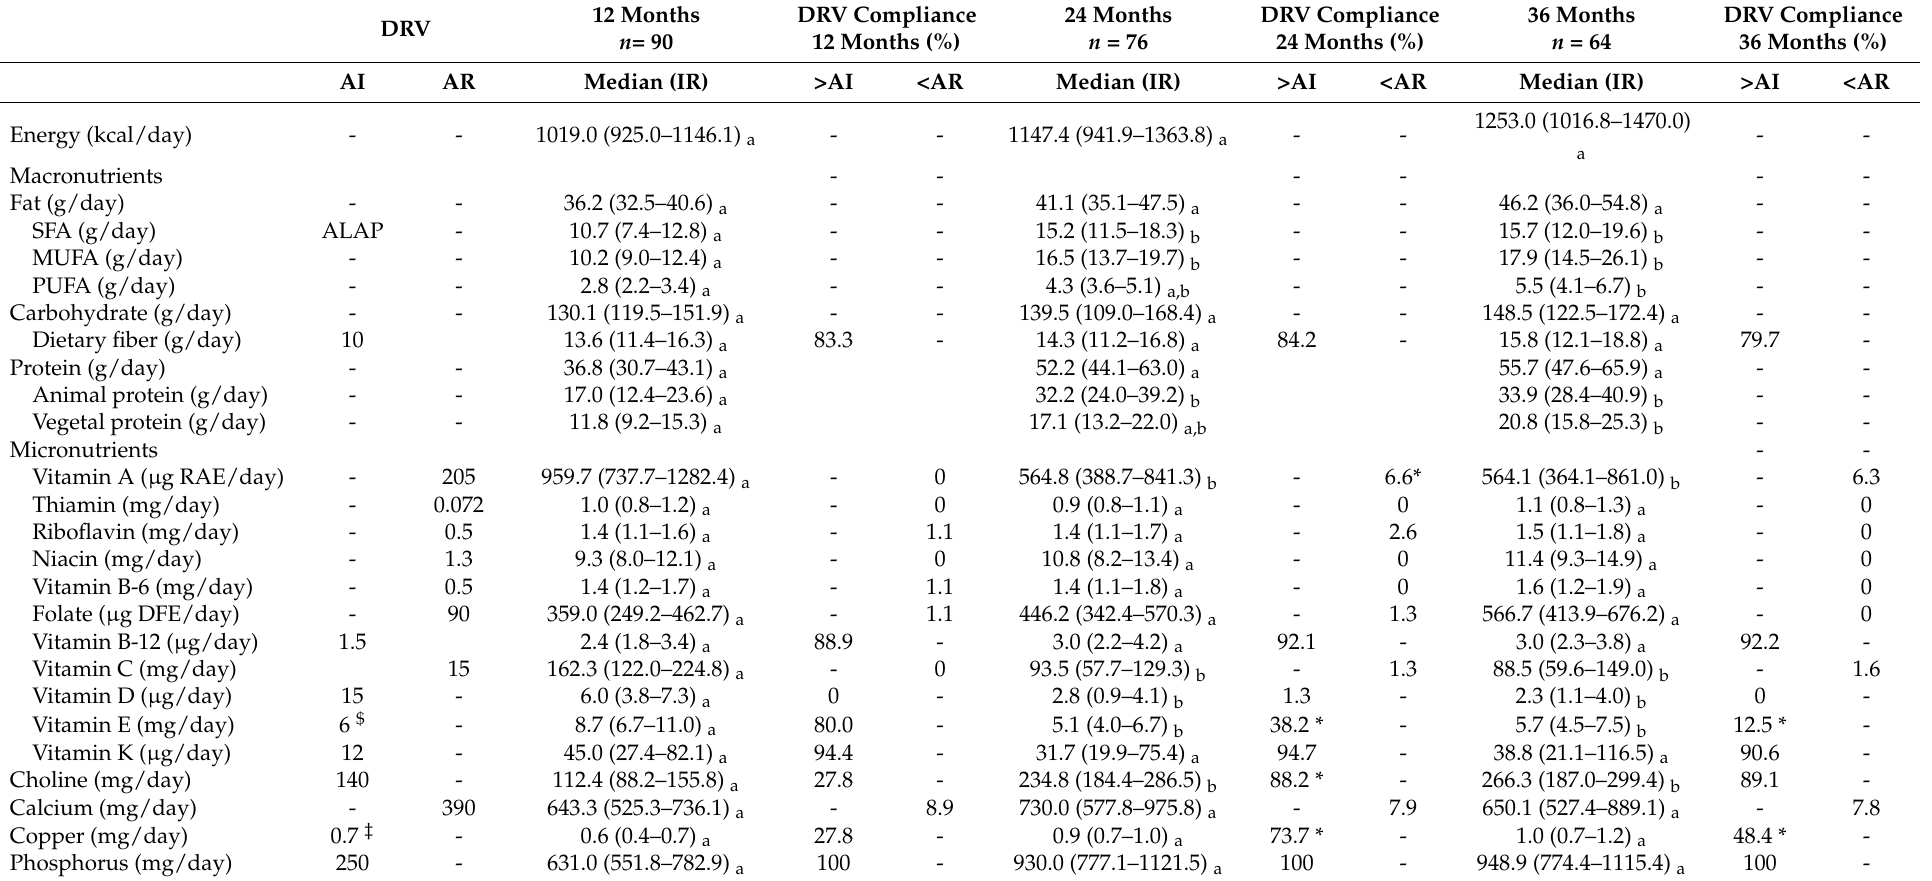
Table 3. Energy and macro- and micronutrients intake compared with dietary reference values (DRVs) based on intakes from the EFSA (European Food Safety Authority) in the study’s cohort at 12, 24 and 36